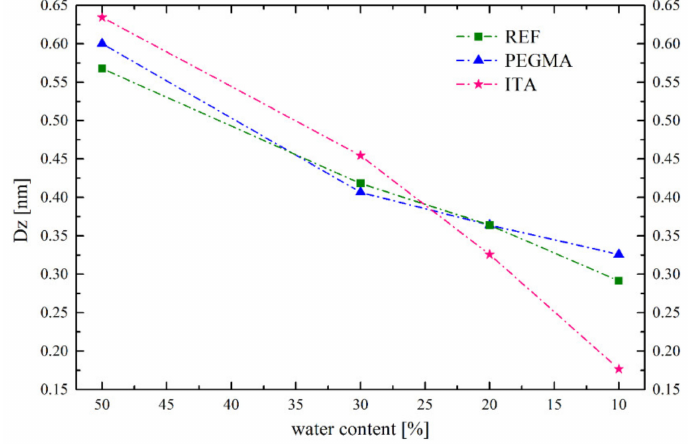
Figure 14. Water droplet size evolution, estimated form DSC measurements, over the latex drying